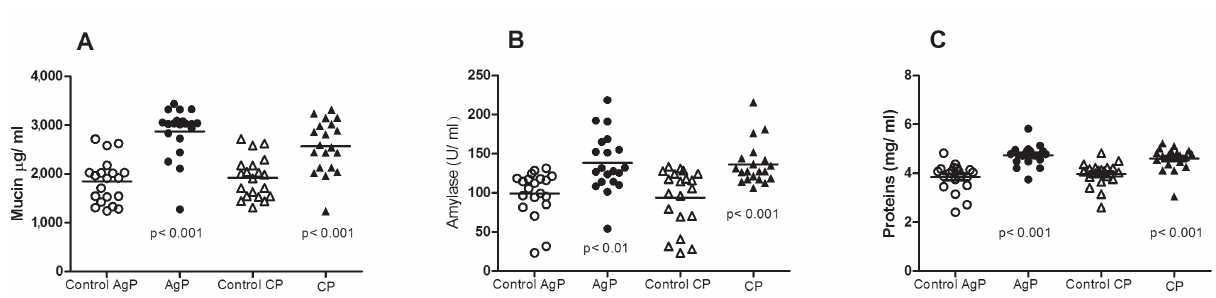
Figure 1- Salivary levels of mucin (A), amylase (B) and proteins (C) in unstimulated saliva from patients with aggressive and chronic periodontal disease and their matched controls